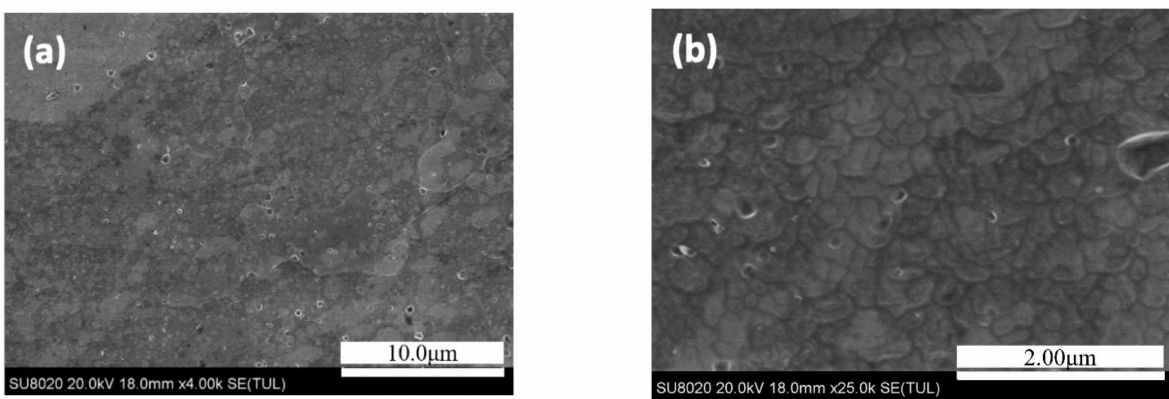
Figure 1. The microstructure morphology and of the 7N01 extrusion aluminum alloy after solution heat treatment: ( a ) SEM images under 4k magnification; ( b ) SEM images under 25k